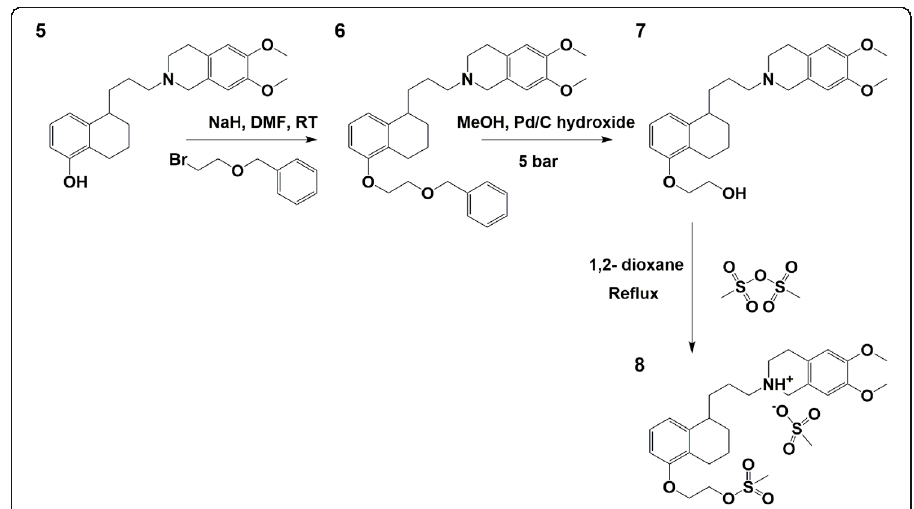
Fig. 3 Synthesis of the MC225 mesylate precursor as its mesylate